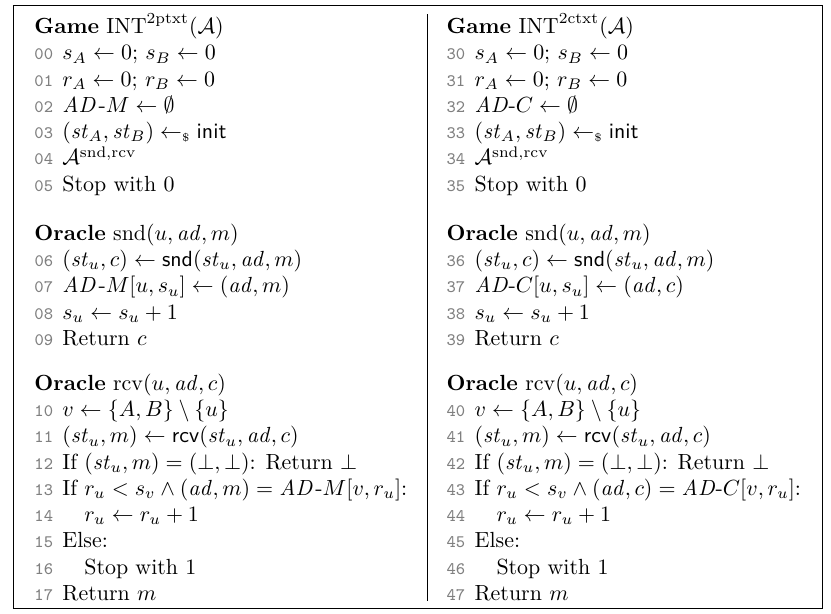
Figure 3: Games for plaintext integrity (left) and ciphertext integrity (right) for bidirec- tional channels. We assume that once an oracle query for a participant results in the participant’s state being set to ⊥ , then no further query for that participant is